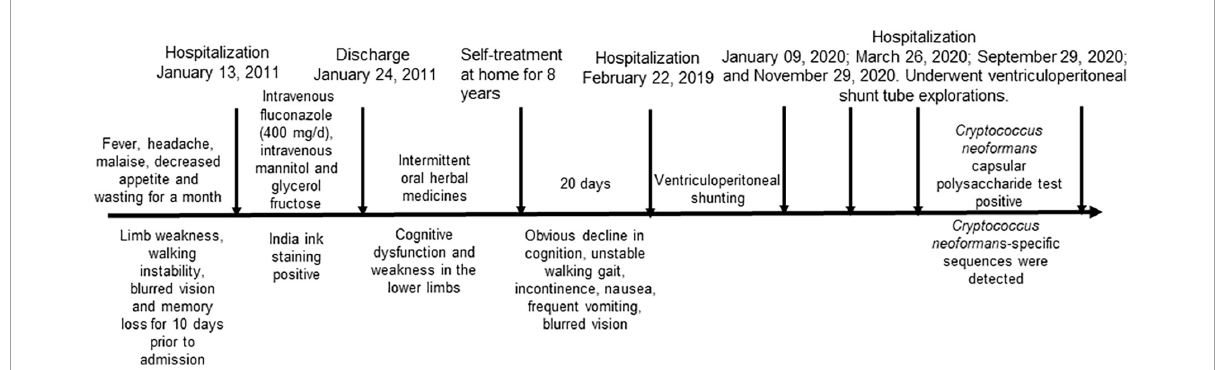
FIGURE2 Timeline of the course of disease